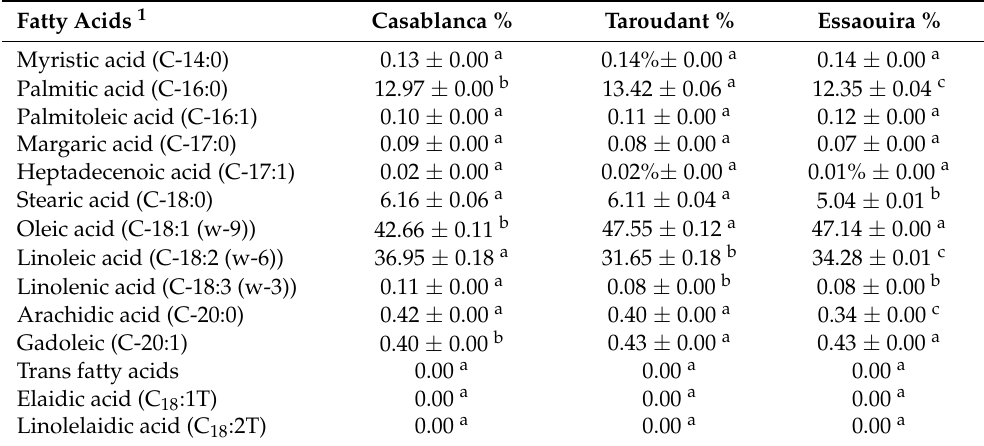
Table 2. Comparison of cis and trans fatty acid concentration (%) of argan oil from argan trees grown on a plantation (Casablanca: AOC) and in two natural forest stands (Taroudant: AOT and Essaouira: